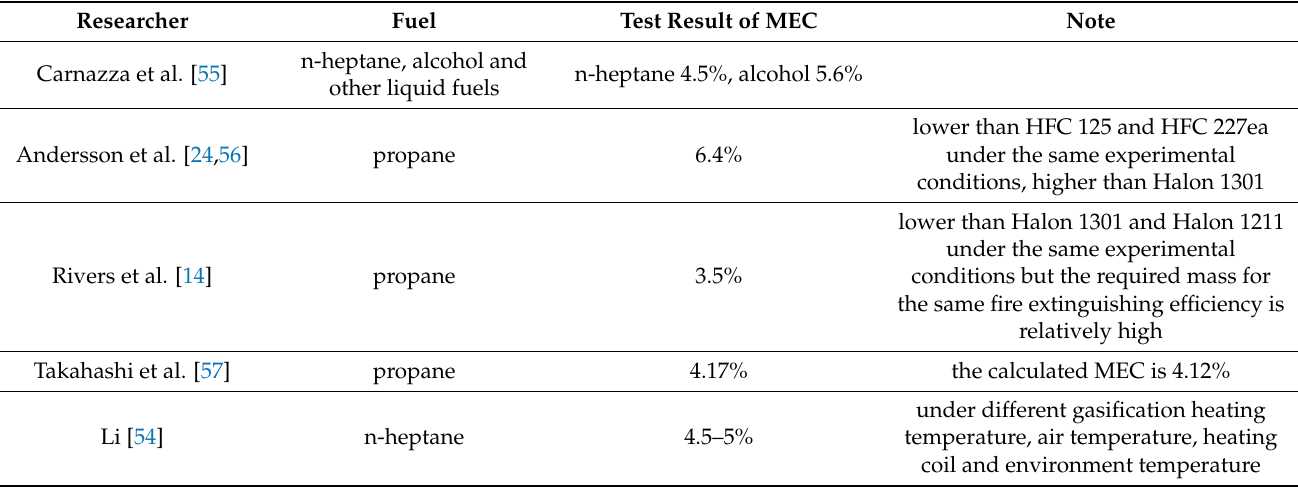
Table 6. Measurement of critical fire-extinguishing concentration of C 6 F 12 O based on cup